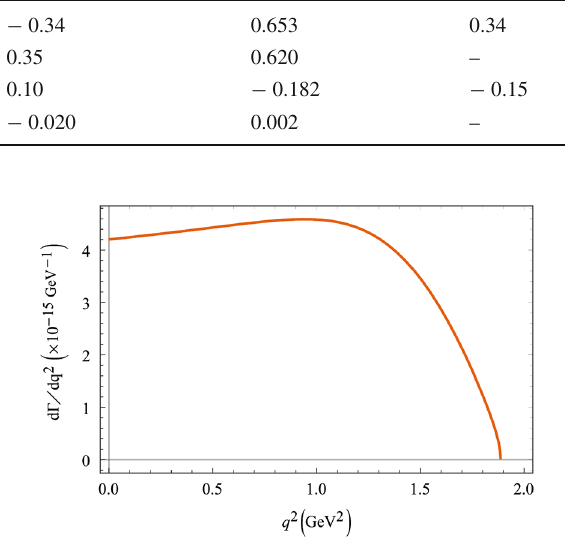
√ s 0 = 3 . 3 GeV ∼ 3 . 5 GeV, and the mass excited states was √ s 0 = 3 . 4 GeV. So the threshold of s 0 was calculated at